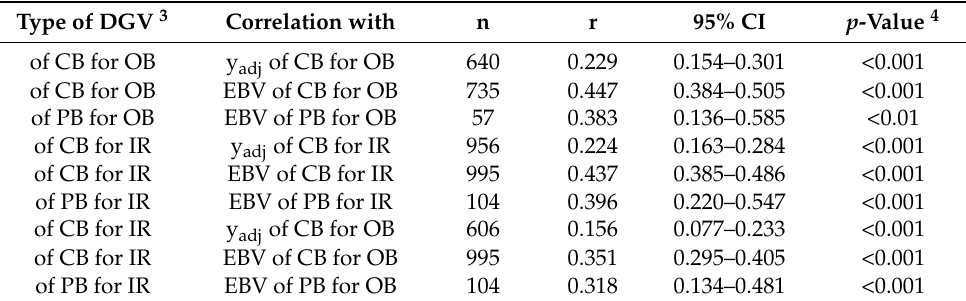
Table 4. Correlations (r) between direct genomic values (DGV) and pre-corrected phenotypes (y adj ) or estimated breeding values (EBV) for observed (OB) and infrared-predicted (IR) ham weight loss estimated in the leave-one-family-out validation 1,2